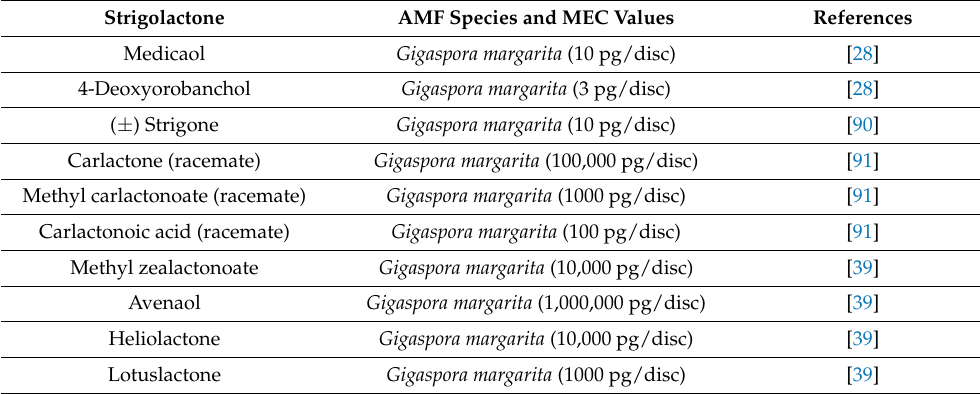
Table 3. Growth-stimulatory activity on arbuscular mycorrhizal fungi hyphae by the new strigolac- tones described since 2015